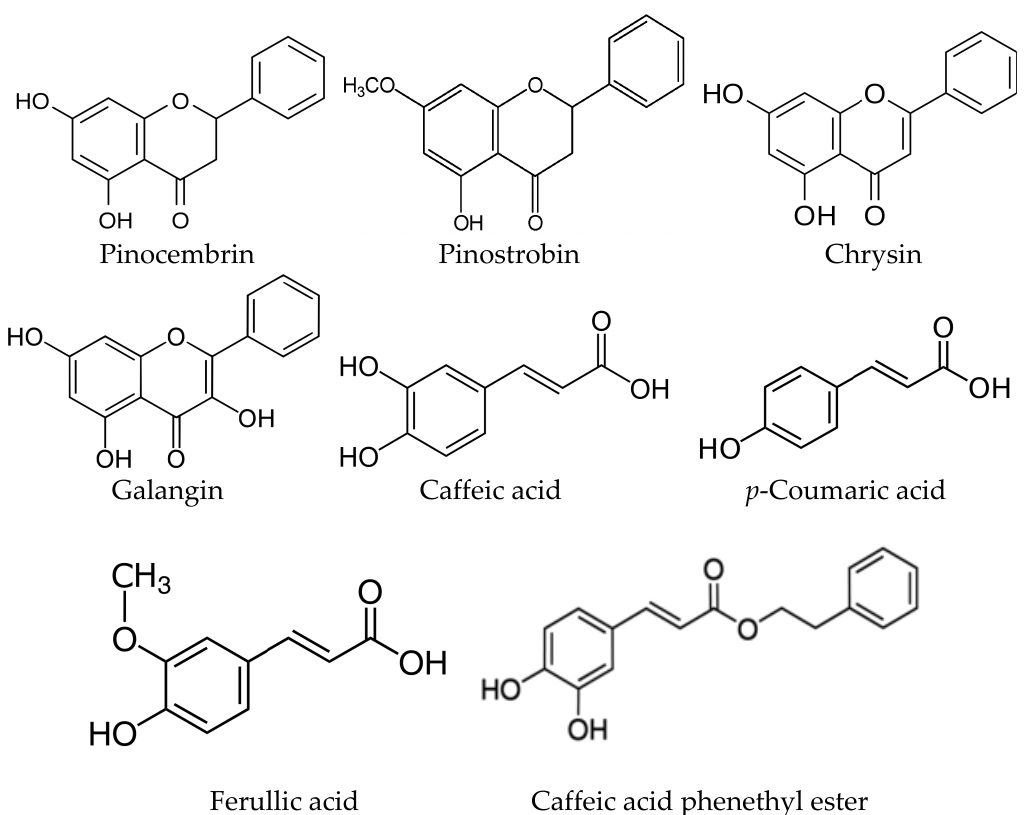
Figure 1. Chemical structures of the most important polyphenolic compounds of Populus bud extracts.